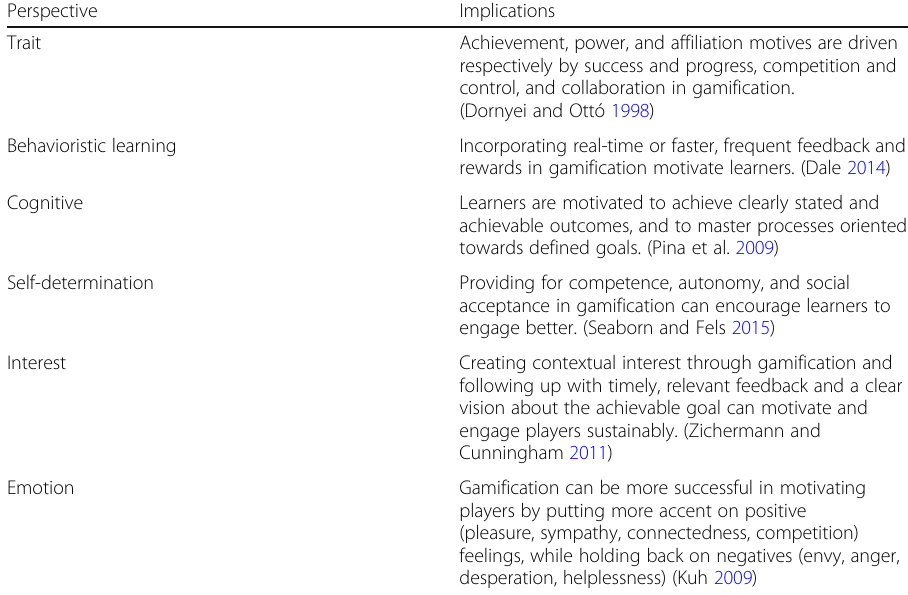
Table 1 Motivation: Perspectives and implications (adapted from (Flores 2015)) Perspective Implications Trait Achievement, power, and affiliation motives are driven respectively by success and progress, competition and control, and collaboration in gamification. (Dornyei and Ottó 1998) Behavioristic learning